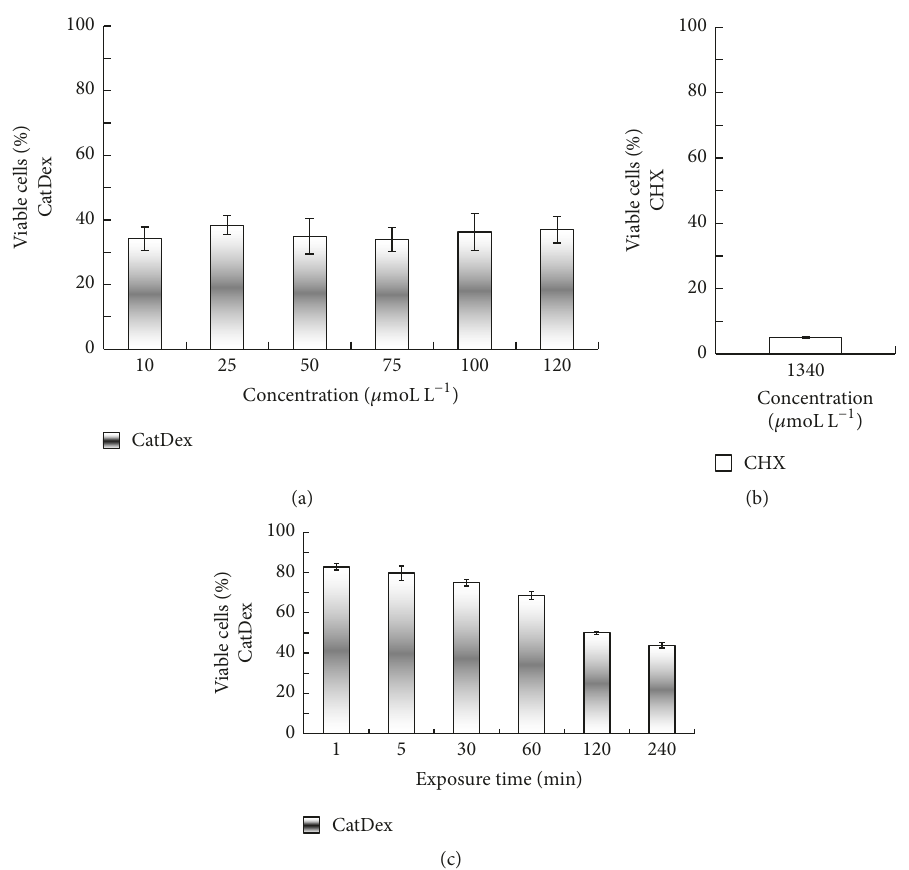
Figure 5: Cytotoxic effect at different concentrations of CatDex and CHX for 24 h at 50 𝜇 moLL −1 (a) and 1340 𝜇 moL L −1 (b), respectively, and for 240 min (c) on dental pulp stem cells (DPSCs). No correlation was found between viable cell percentage and CatDex concentration ( 𝑝 < 0.0